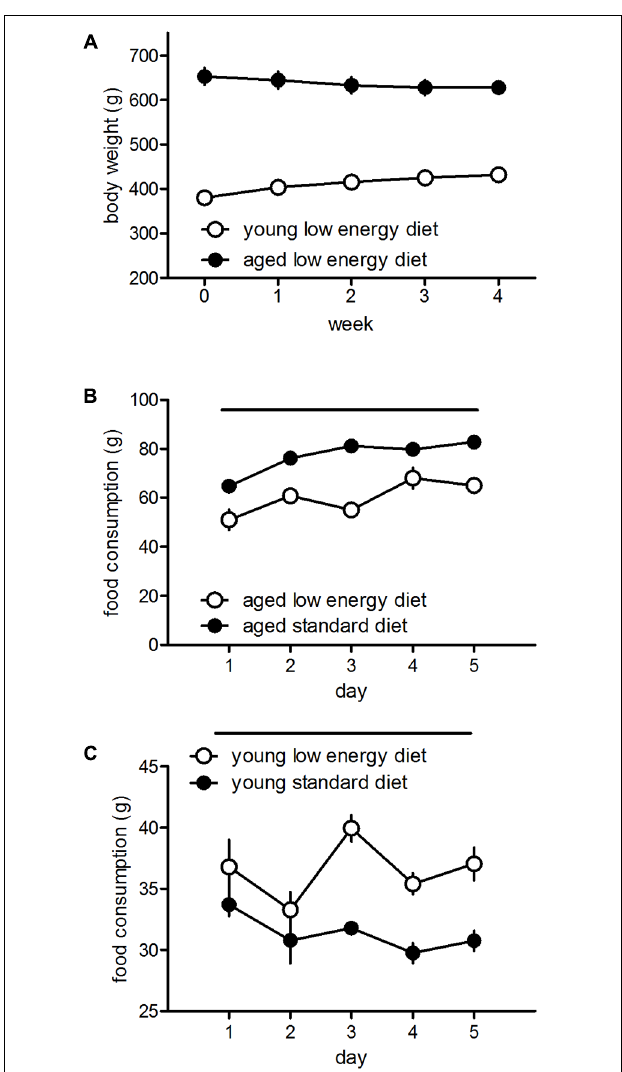
FIGURE 3 | Development of body weights over 4 weeks of the aged ( n = 14) and young ( n = 20) rats fed with the low energy diet (A) and food intake over 5 days of the aged ( B , five cages with three rats each) and young ( C , four cages with three rats each) rats fed with the low energy or standard diet. Horizontal bars indicate statistically significant differences between groups. Given are the means and standard errors of